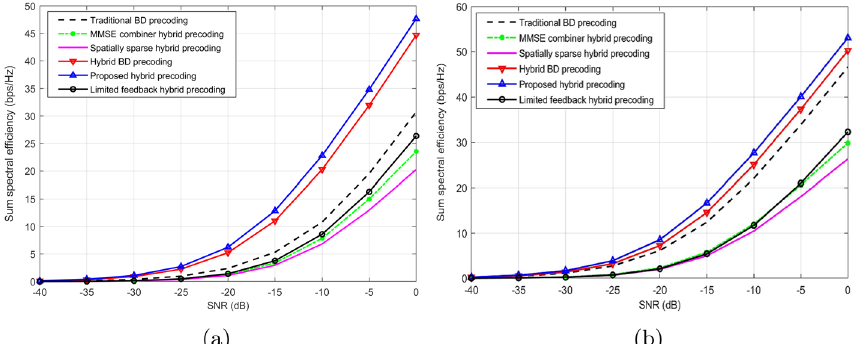
Fig. 2 Achievable spectral efficiency comparison for the MIMO system in ( a ) mmWave channel; ( b ) Rayleigh channel